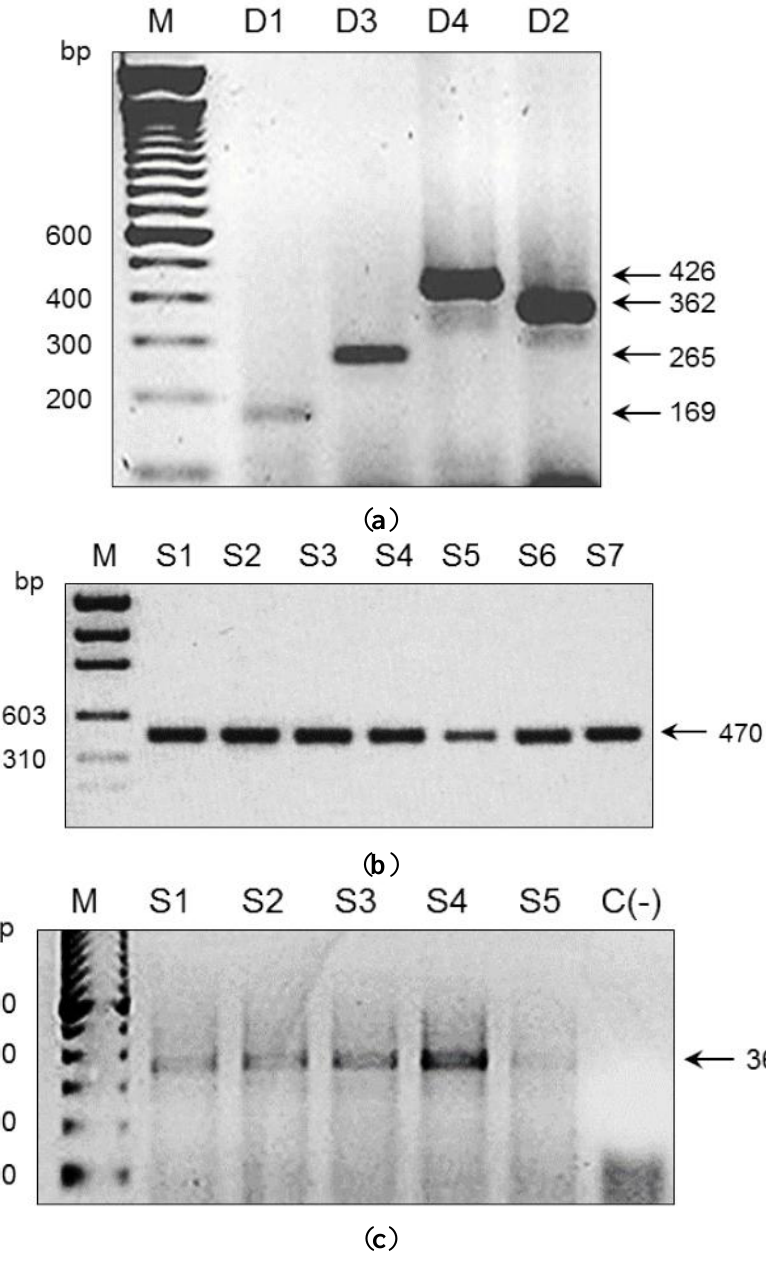
Figure 3. Amplification products of RT-PCR consensus and serotype-specific primer pairs. The RT-PCR products were observed in ethidium bromide-stained agarose gels (2%). Input viral RNAs were extracted from each control dengue virus strain. Results for serotypes DEN-1, DEN-2, DEN-3, and DEN-4 are shown. ( a ) The 169-, 362-, 265-, and 426-bp amplicons for DEN-1, DEN-2, DEN-3, and DEN-4, respectively. ( b ) The 470-bp amplicons expected for all four dengue serotypes using the consensus primers. ( c ) The 362-bp amplicons for DEN-2 obtained from five